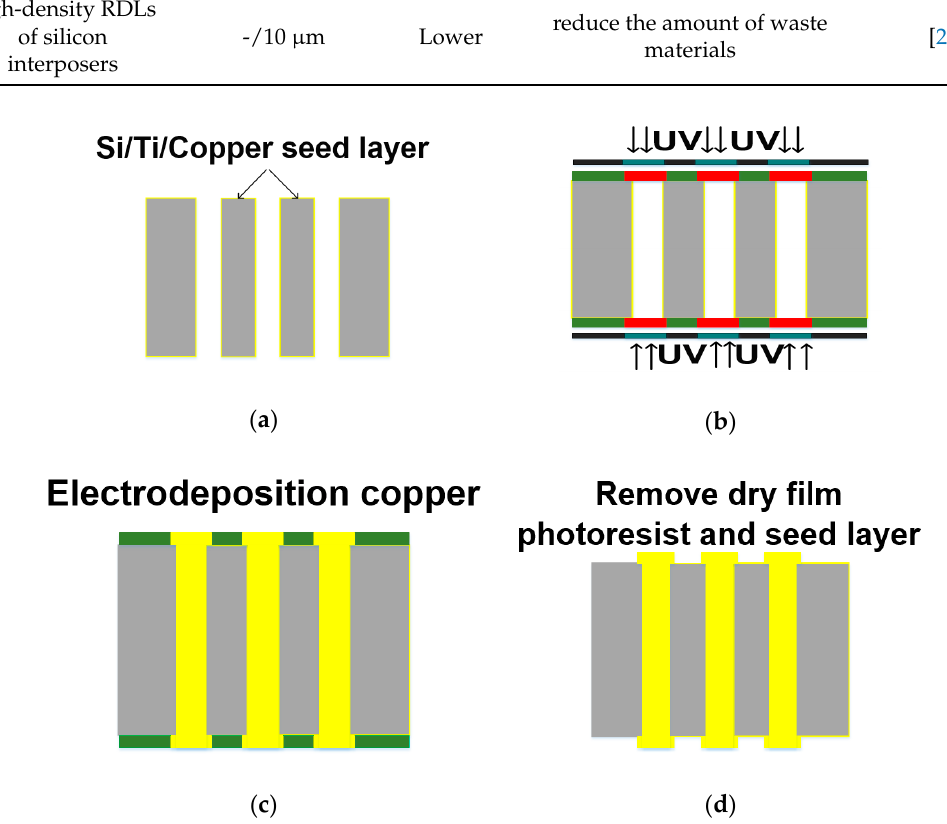
Figure 1. Silicon interposer through electrical copper coating technology production: ( a ) The construction of through-silicon via on the wafer; ( b ) The dry film etchant is stuck on the wafer, then exposed and etched; ( c ) Hole plating and pad fabrication by electroplating methods; ( d ) The photoresist removing. Adapted with permission from [27], Copyright Elsevier,